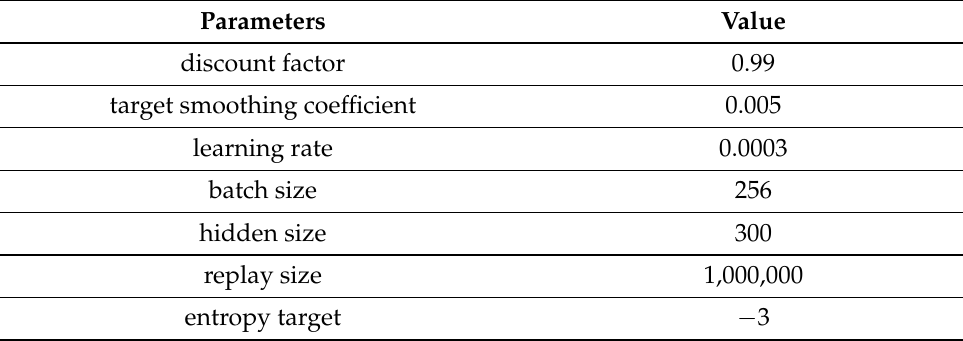
Table 3. Parameters of SAC −